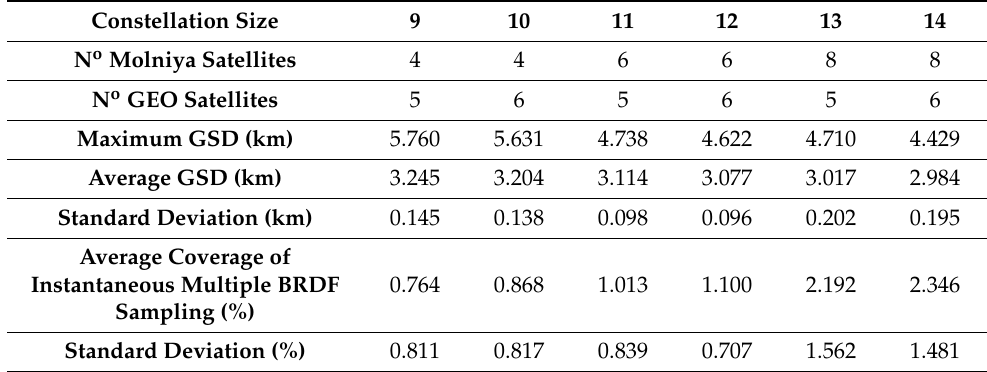
Table 7. Summary of quality of coverage for varying GEO + Molniya constellation